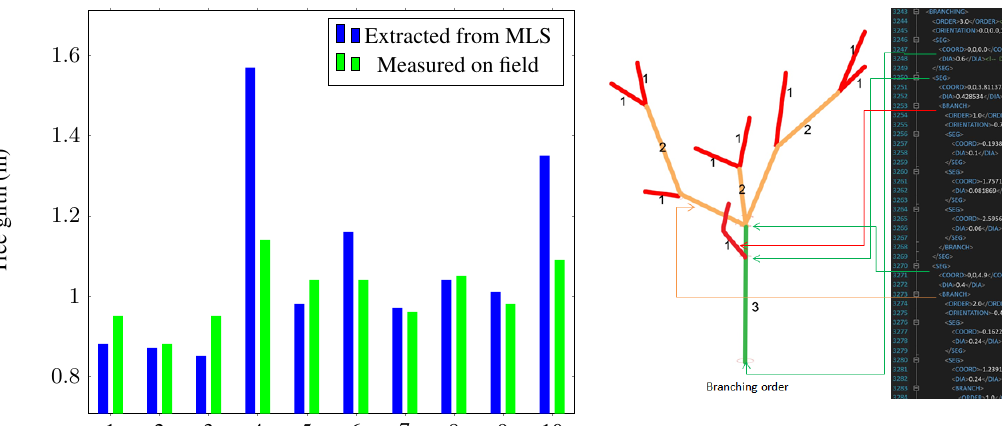
Figure 6. Tree locations Figure 7. Trees isolated from the ground Figure 8. Fitted ellipses